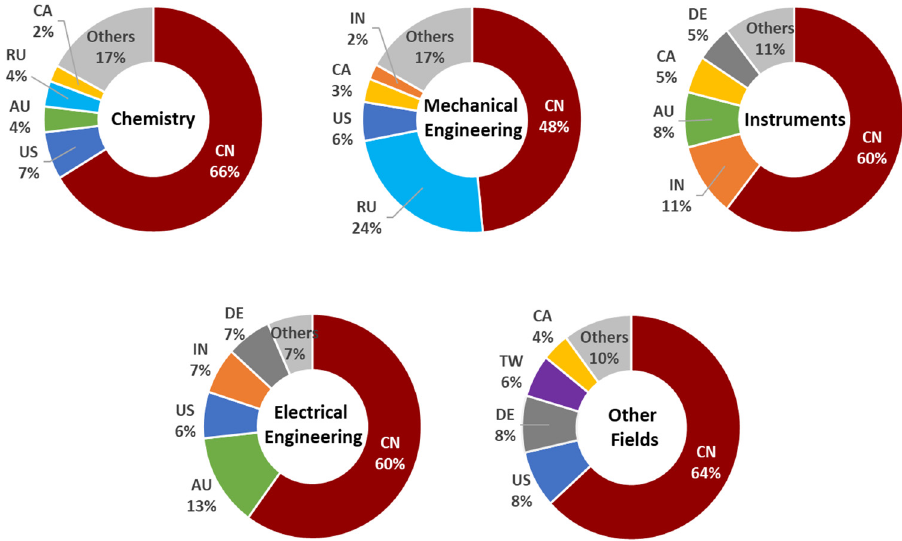
Figure 5. Top five countries in terms of numbers of patents categorized into five clusters in which the same color refers to the same country (Note: CN = China, RU = Russia, US = The United States, AU = Australia, IN = India, CA = Canada, DE = Germany, and TW = Taiwan).